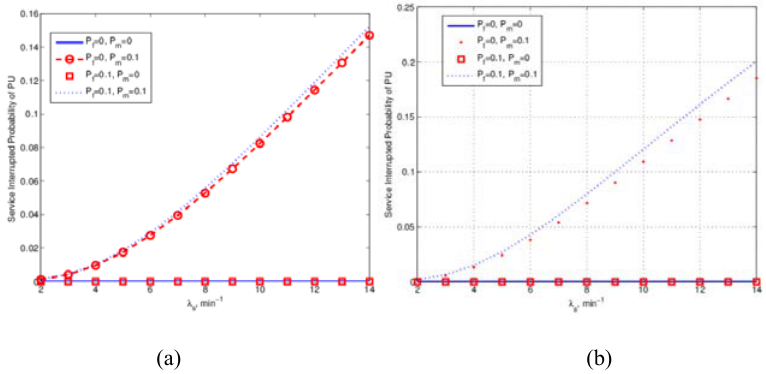
Fig. 6. (a) Service interrupted probabilities of PU for the OSA scheme with non-hopping under imperfect sensing; (b) Service interrupted probabilities of PU for the OSA scheme with hopping under imperfect